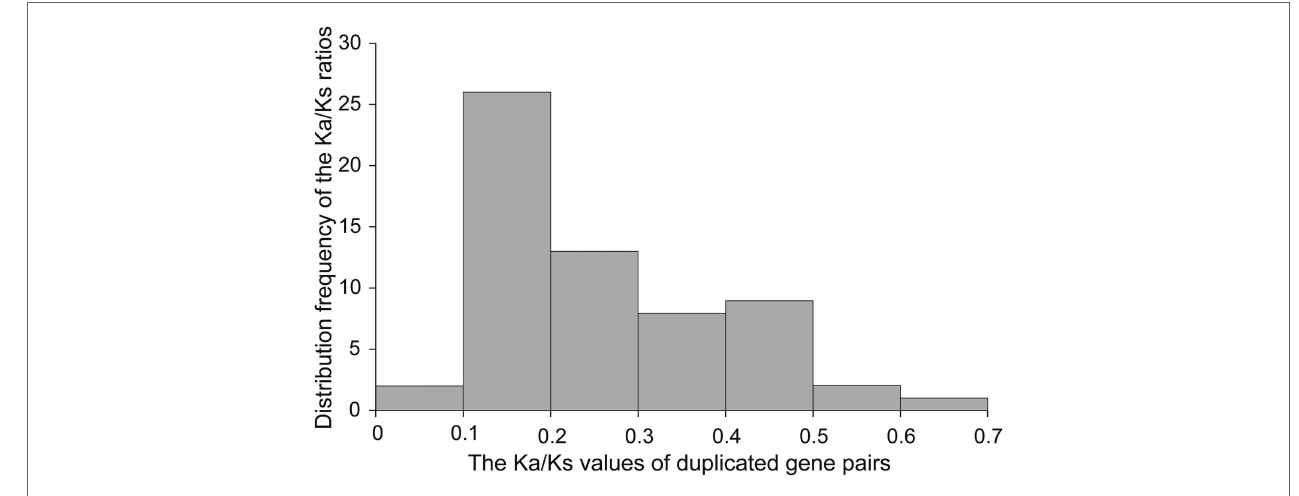
FIGURE 7 | Histogram of distribution frequency of pairwise Ka/Ks ratios for pairs of homologous